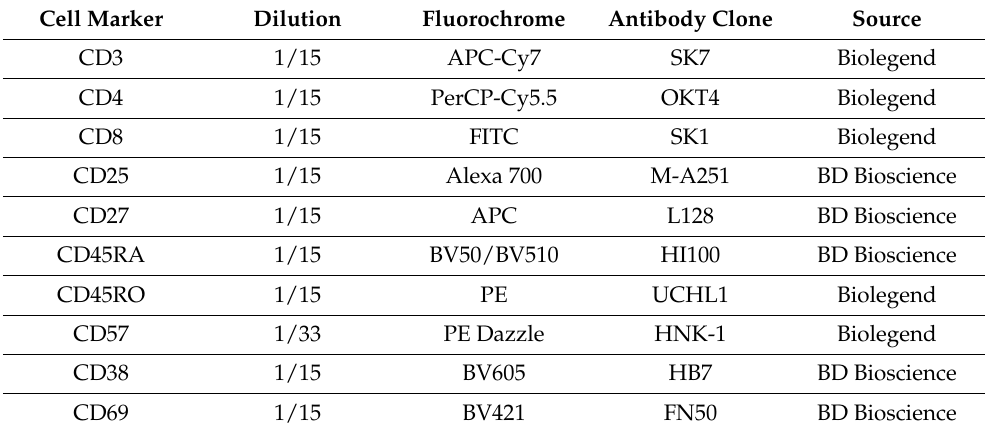
Table 1. Antibodies used for immunological phenotyping of peripheral blood mononuclear cells by flow